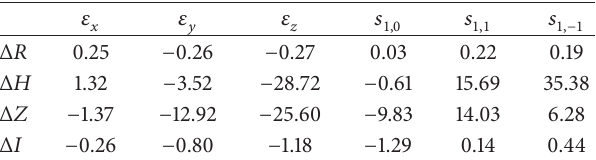
Table 2: Results after four steps (in mas.).